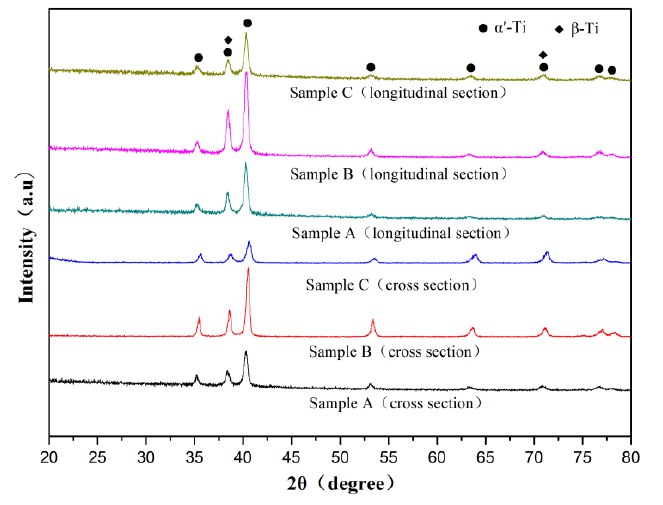
Figure 4. XRD patterns of SLM-produced Ti-6Al-4V samples with different build orientations. Table 2. Phase constituents and their volume fraction of cross section and longitudinal section of SLM-produced Ti-6Al-4V samples with di ff erent build orientations estimated from the XRD patterns.